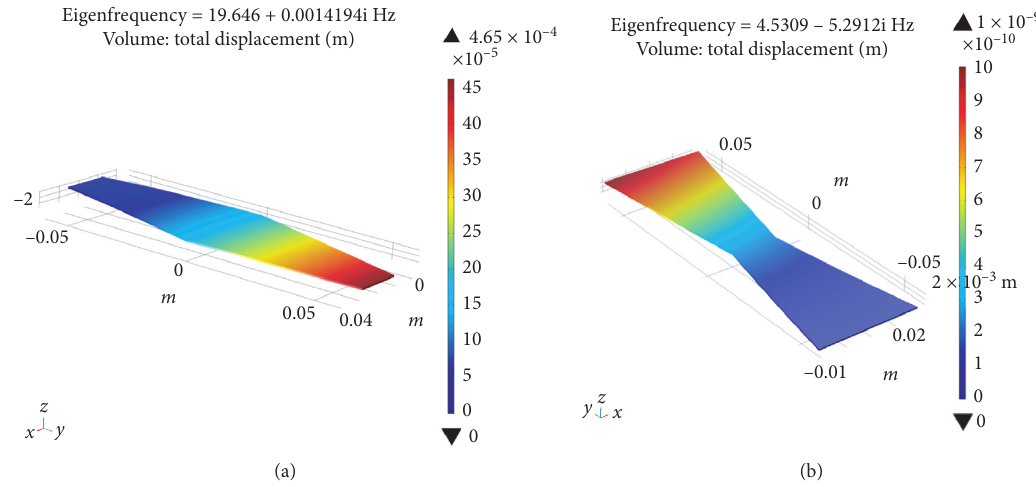
Figure 7: The displacement of two different two-piece trapezoidal piezoelectric bimorph beam which vibrates at its first resonance frequency. (a) The left subplot is the stationary displacement (without deformation) of the first design. (b) The right subplot is the stationary displacement (without deformation) of the second design. The shorter width W 1 is 18mm, and the longer width W 2 is 40 mm for both two bimorph designs. The length of the beam L is 60mm, the thickness of T piezo is 0.3mm, and the thickness of the brass layer T s is 0.05mm.